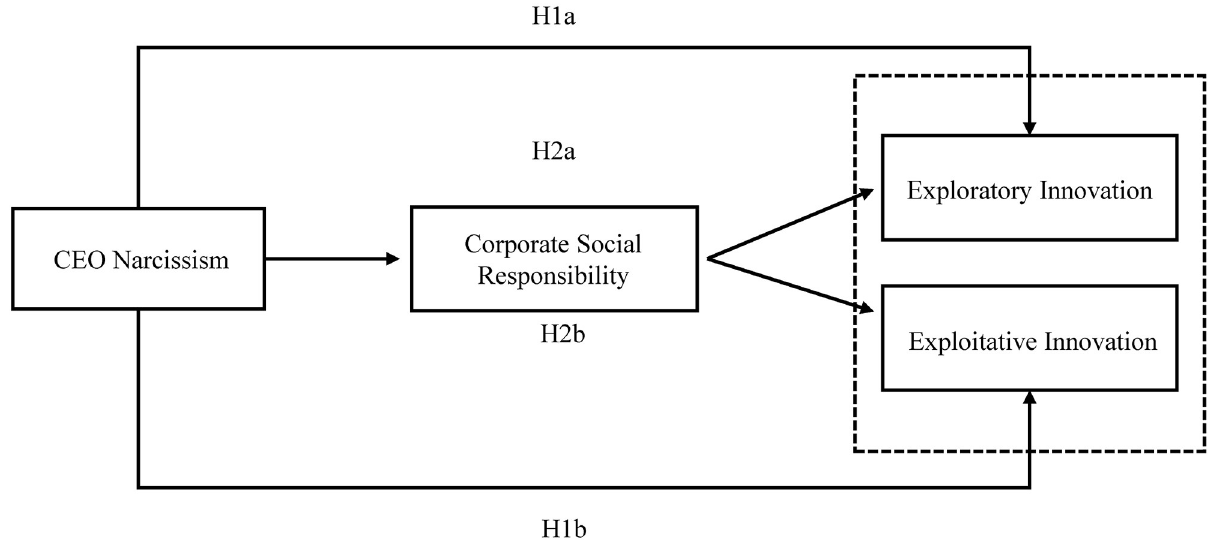
Fig 1. Research hypothesis